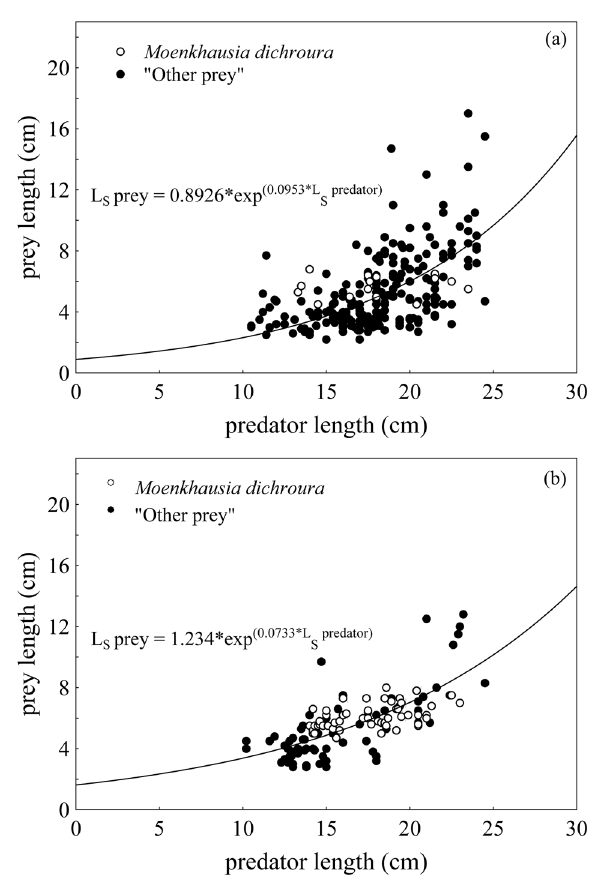
Fig. 5. Regression analysis between predator length ( Acestro- rhynchus pantaneiro ) and prey length for sampling periods I (a) and II (b) at Manso Reservoir, Mato Grosso State, Brazil, followed by their respective equations fitted by the model (n = 379; 255-period I and 124- period